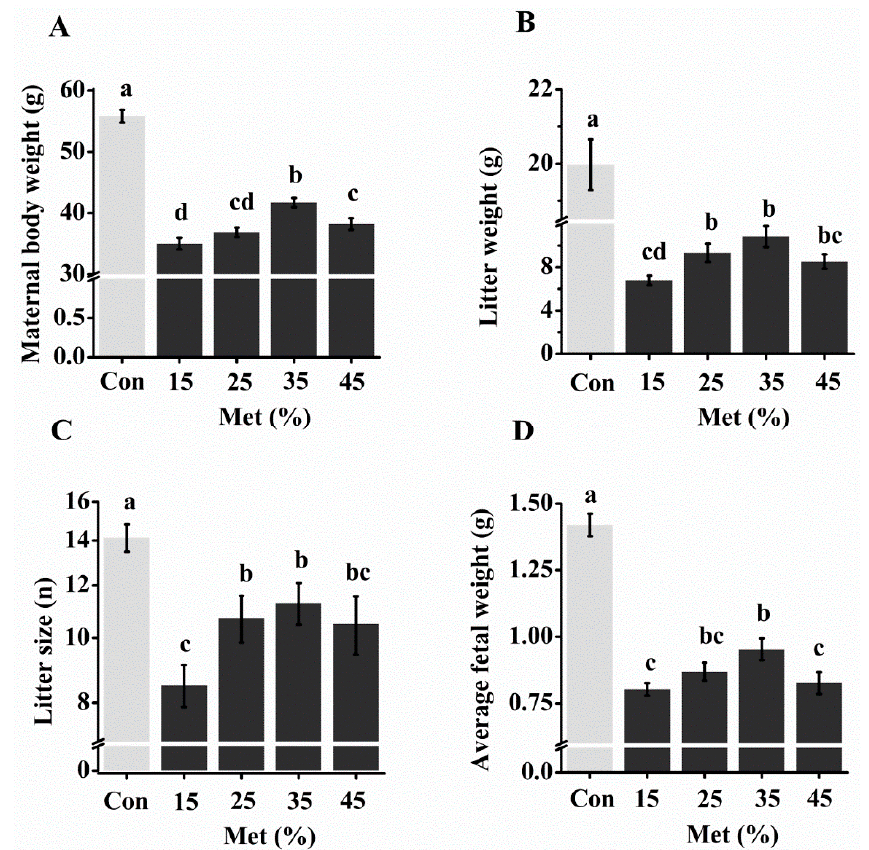
Figure 2. Maternal body weight ( A ), litter weight ( B ), litter size ( C ), and average fetal weight ( D ) at day 17 with different free methionine (Met) supplementation regimens. The control group (Con) was fed a diet with Met, whereas the 15–45% Met groups were fed a Met-deficient diet supplemented with 15, 25, 35, or 45% of the Met in the control diet by intraperitoneally injection from conception. The data are expressed as the mean ± SEM, n = 6–7. The different letters indicate significant differences, p < 0.05.